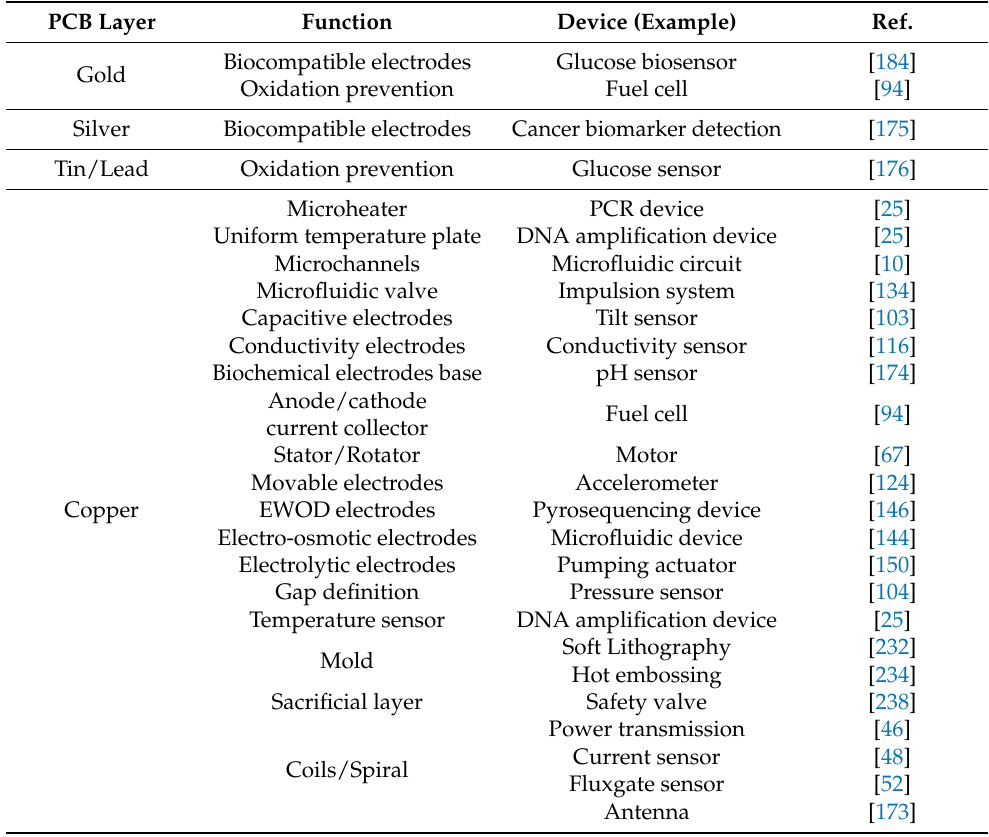
Table 1. Metallic layers functions and devices.